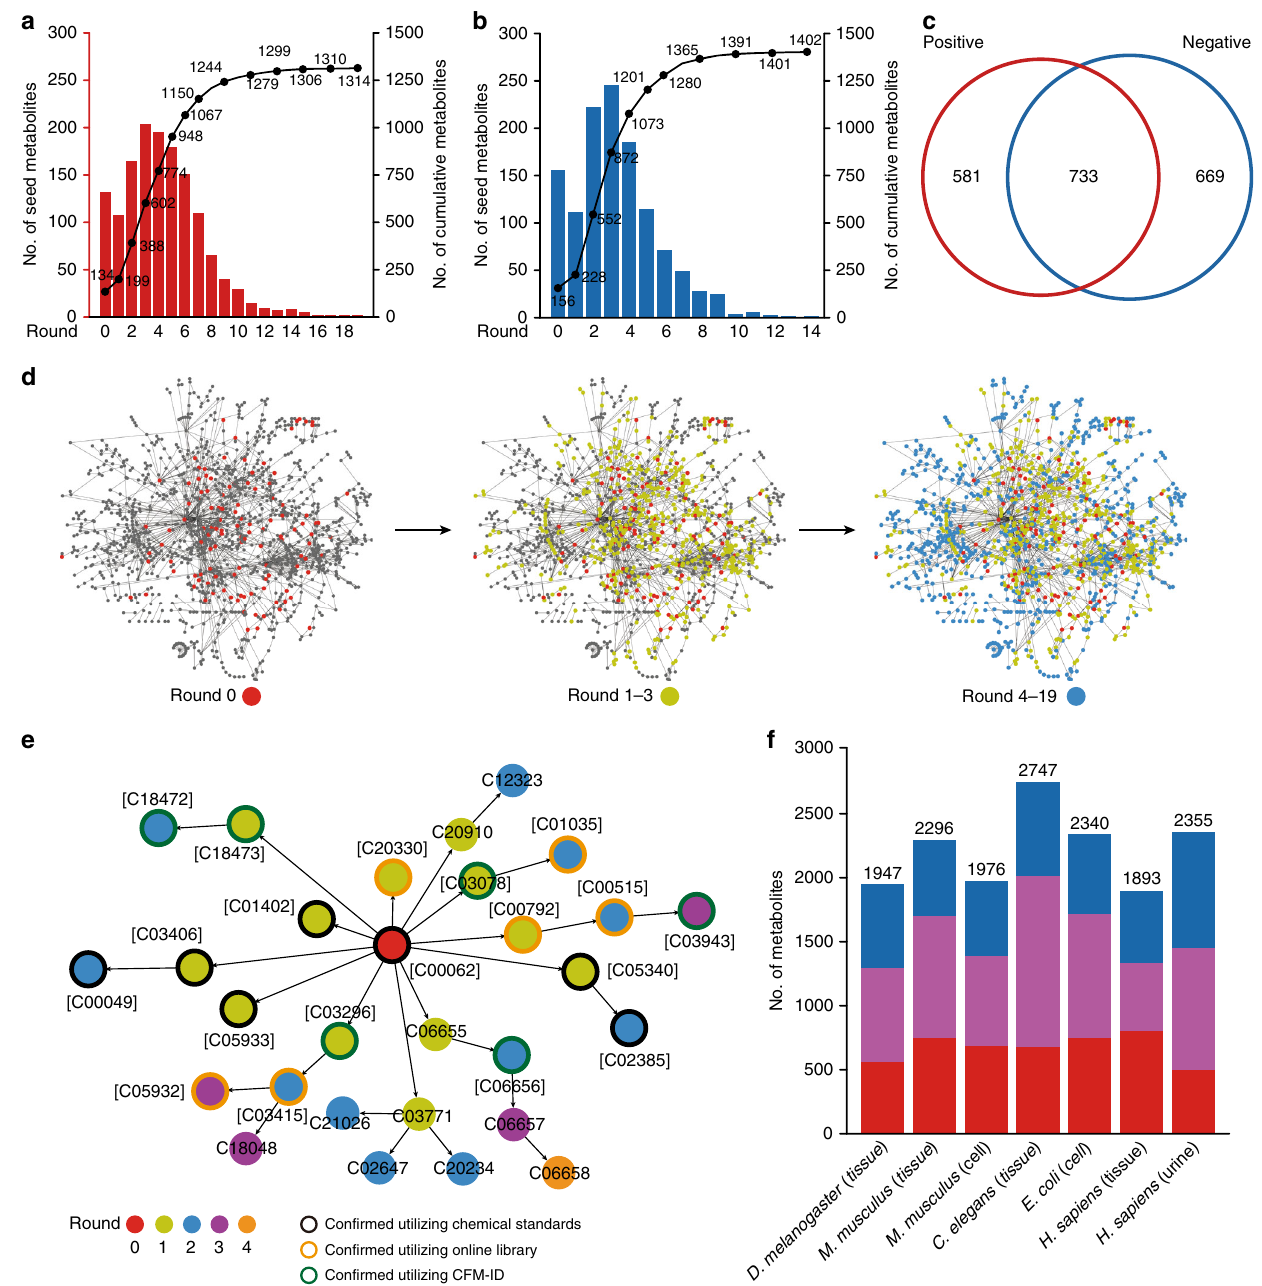
Fig. 2 Metabolic reaction network (MRN)-based recursive metabolite annotation. The numbers of annotated metabolites in Drosophila aging datasets: a positive and b negative modes. The left y -axis of the plot is the number of seed metabolites in each round, and the right y -axis of the plot is the cumulative number of annotated metabolites. c A Venn diagram showing the overlap of annotated metabolites in positive (red) and negative modes (blue). d Network diagrams demonstrating the distributions of annotated metabolites in round 0 (left, red), rounds 1 – 3 (middle, yellow), and rounds 4 – 19 (right, blue). e An example of initial seed metabolite ( L -arginine) is given to demonstrate how MetDNA identi fi es 28 reaction-paired neighbor metabolites. f The numbers of annotated metabolites in different biological species and samples. The red, blue, and purple bars represent the results from the positive mode, negative mode, and the overlap between the positive and negative modes,